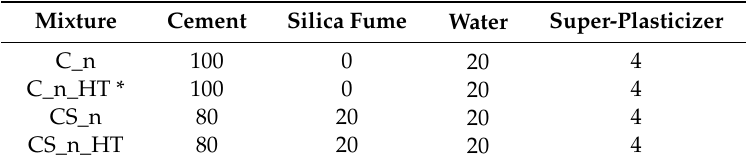
Table 1. Mix proportions of specimens by weight percentage of cement, wt.%.